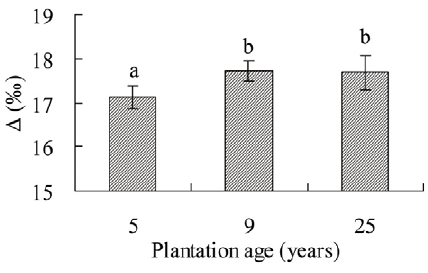
Figure 5. Leaf carbon isotope discrimination of different ages of Caraganaintermedia plantations. Four replicates of mature leave sample was take in each age of C. intermedia plantations.